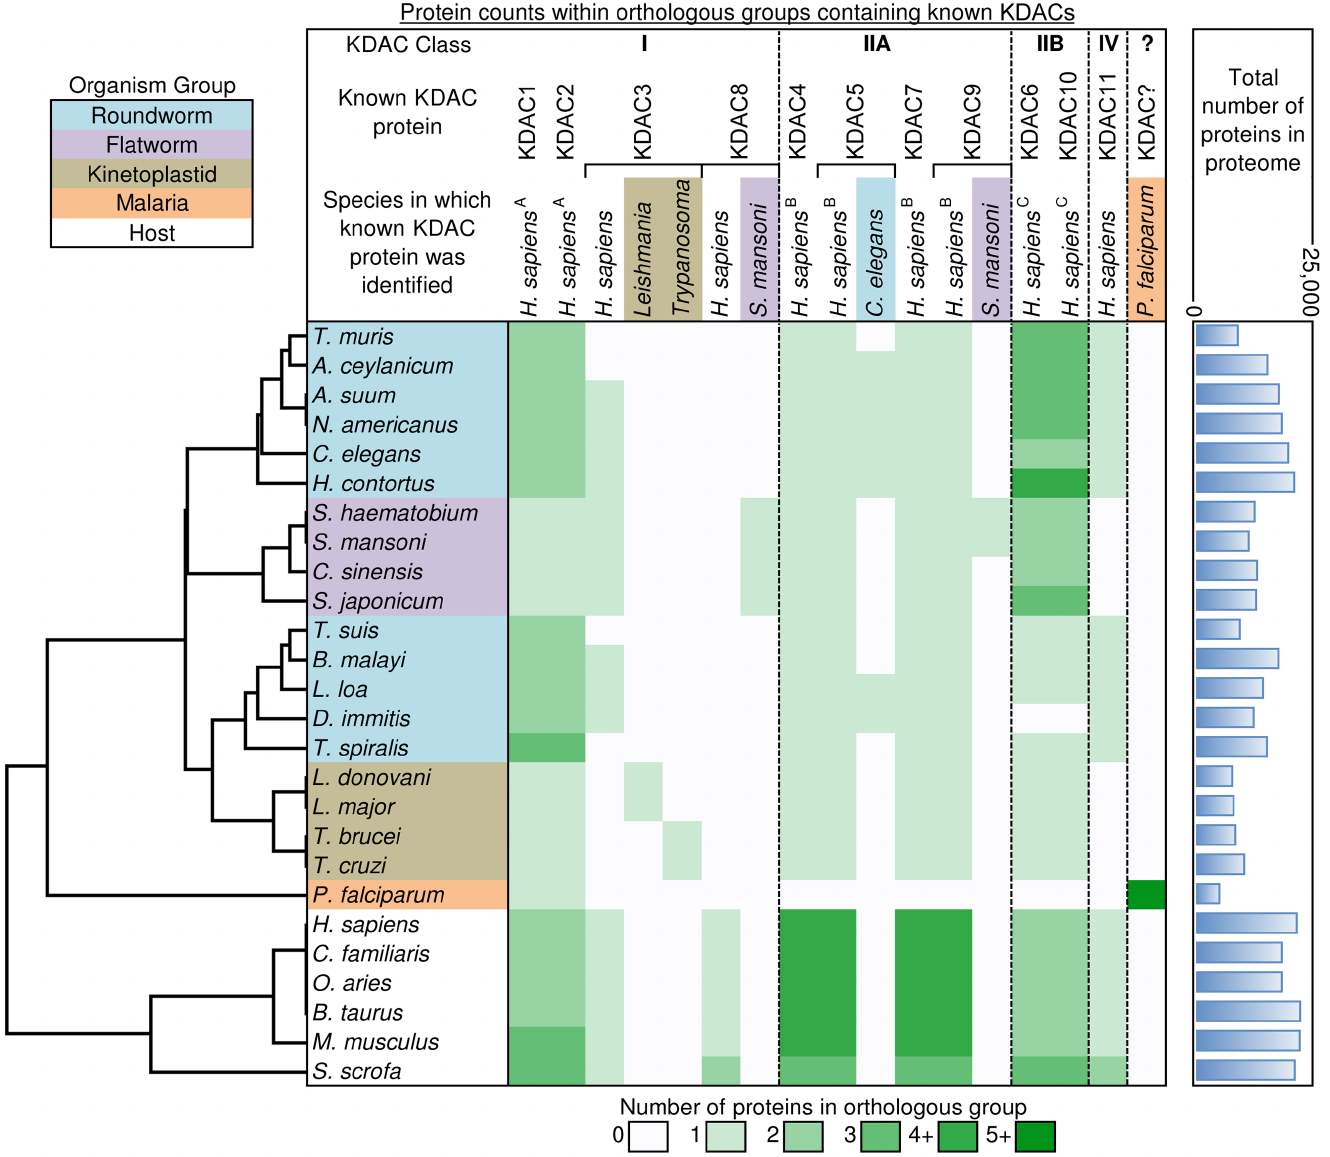
Fig 2. KDAC proteins inferred for the parasitic species within protein families. Those with the same superscripts (A, B, C) are clustered within the same family. Color codes provide the number of total proteins from each species within an orthologous protein